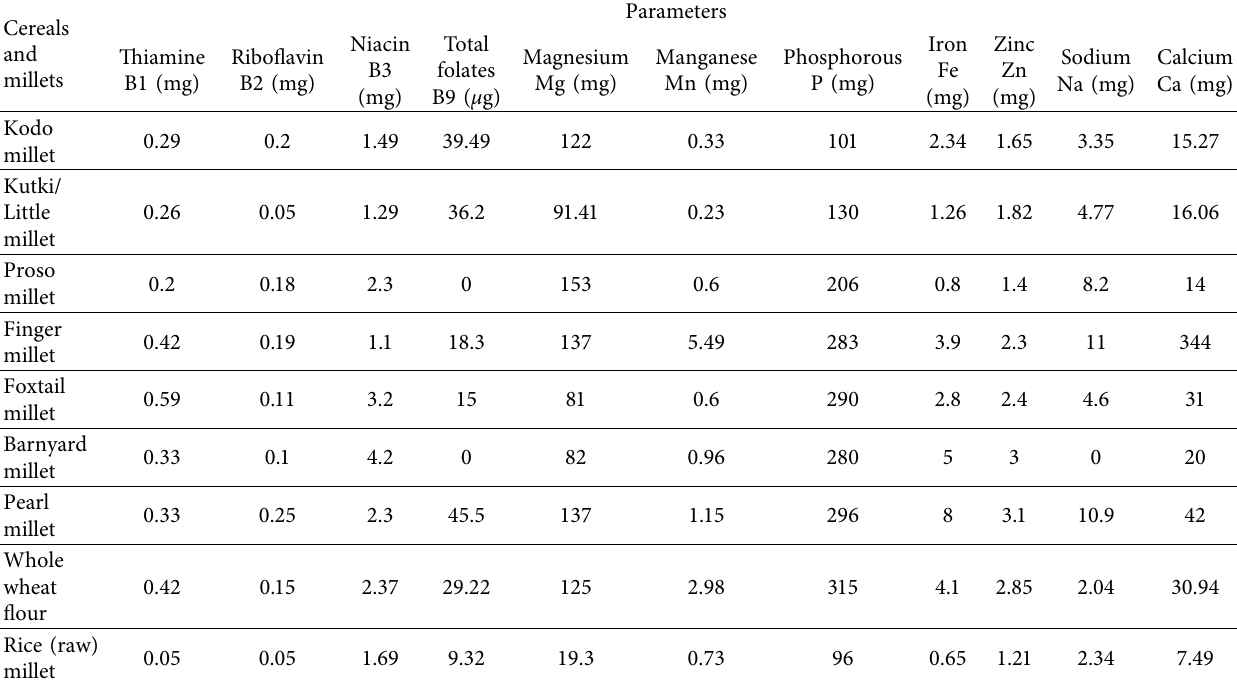
Table 2: Vitamin and mineral profile of millets compared to